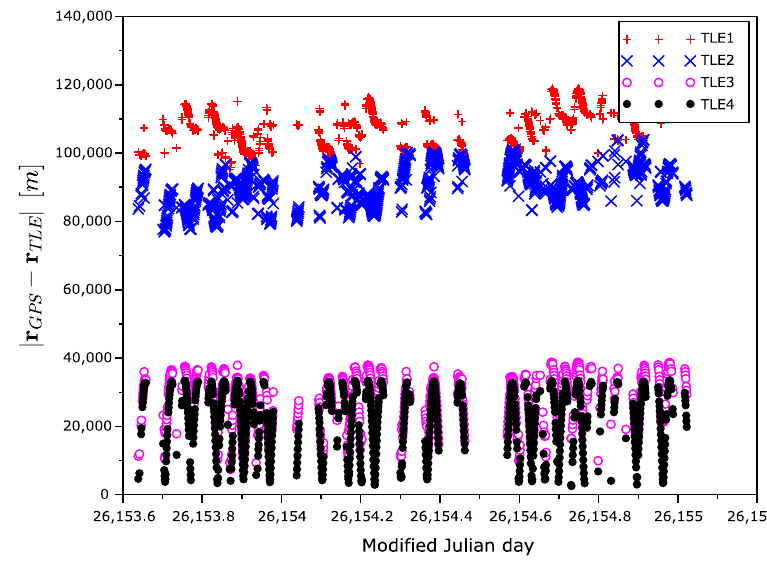
Figure 5. Position error magnitude as a function of time.